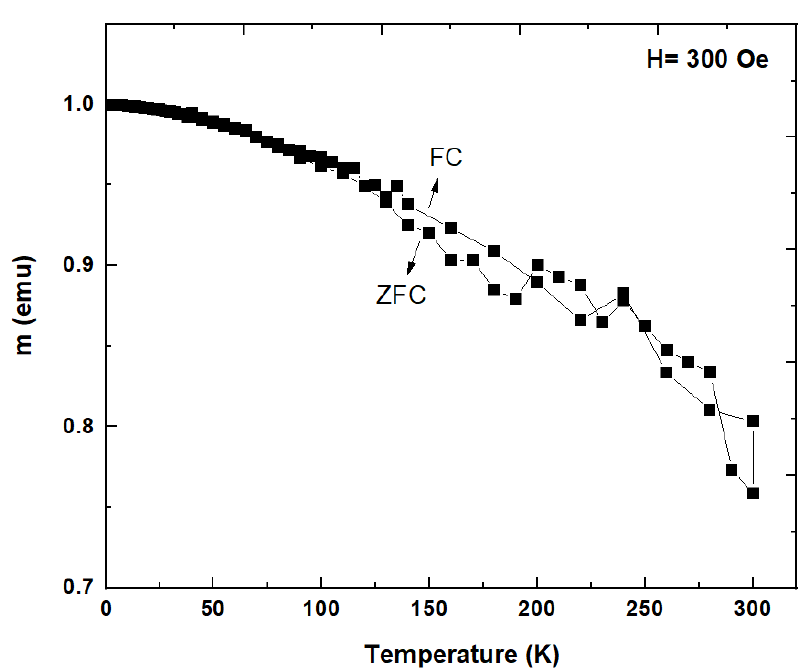
Figure 7. The temperature dependence of the magnetization in the field-cooled (FC) and zero field- cooled (ZFC) regime recorded on Yb 3+ /Er 3+ -doped SiO 2 -GdF 3 /LiGdF 4 nano-glass ceramic (2LiGC) under 300 Oe applied magnetic field